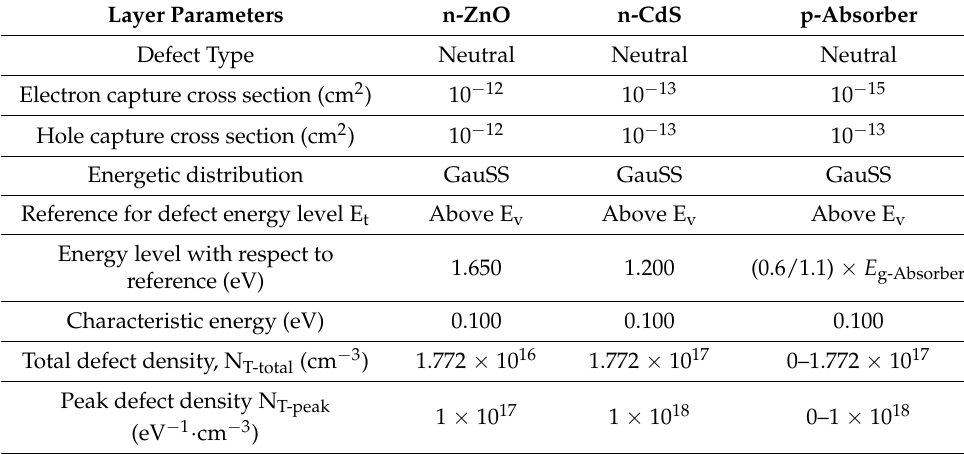
Table 4. Defect properties of all layers used in this